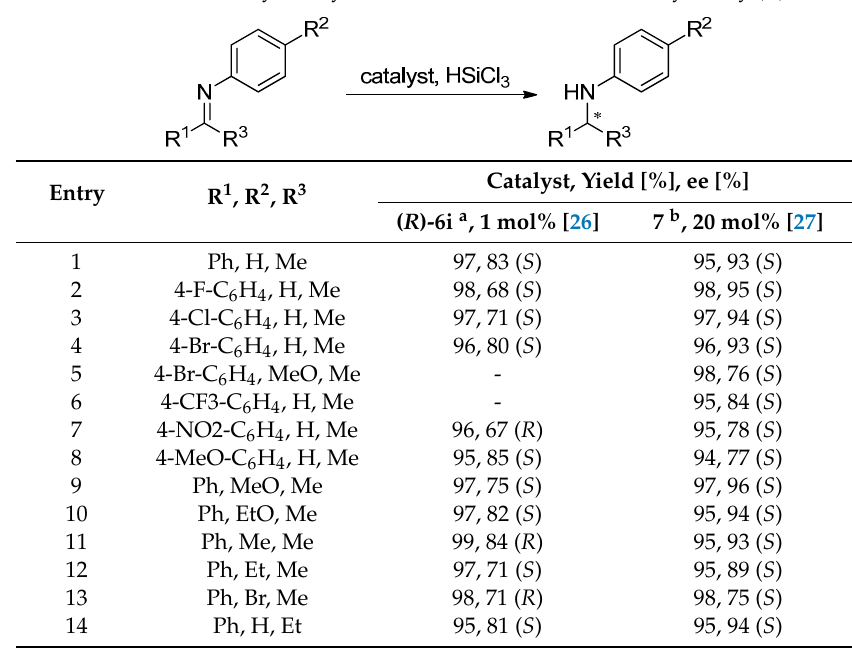
Table 2. Enantioselective hydrosilylation of various ketoimines catalyzed by ( R )- 6i and 7 .